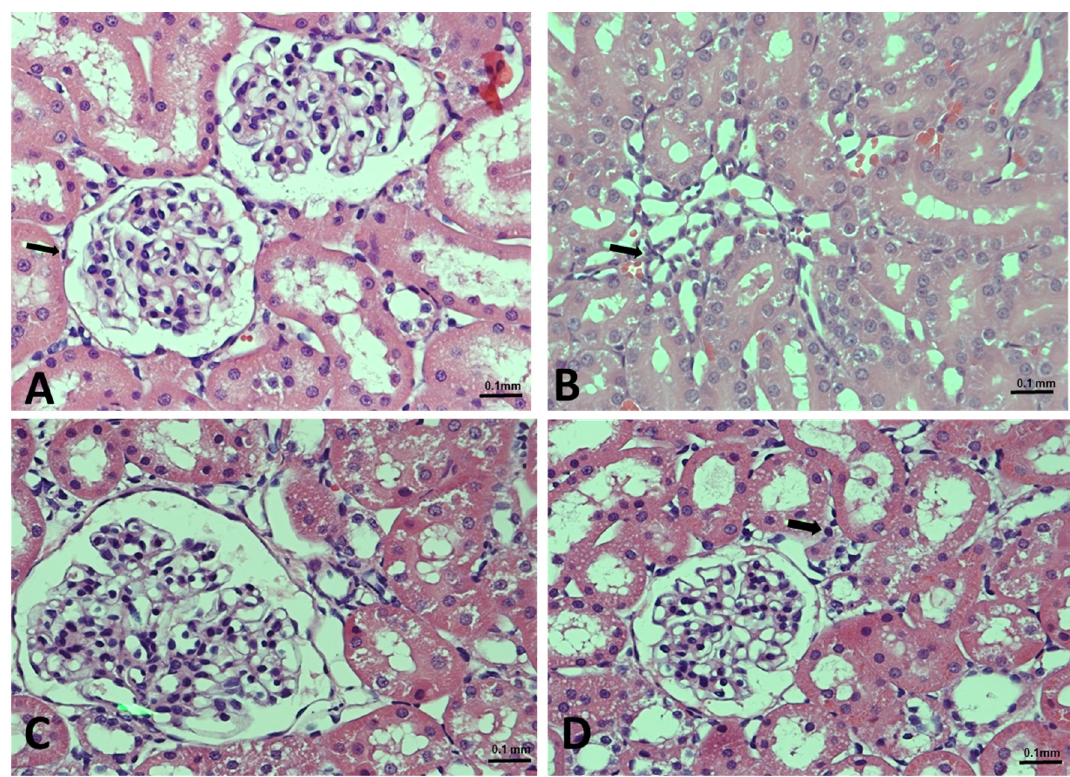
Figure 6. ( A – D ). Effects of geraniol (Gr), doxorubicin (Dox), or their combination (Dox + Gr100 and Dox + Gr200) on kidney tissue as visualized using H&E staining and light microscopy: ( A ) normal architecture of the kidney; ( B ) mild interstitial inflammation (indicated by arrows) consisting of lymphocytes, caused by Dox administration; and ( C , D ) geraniol-treatment-improved glomeruli, tubules, and tubular epithelial cell morphology at both tested doses. Scale bar is 0.1 mm.